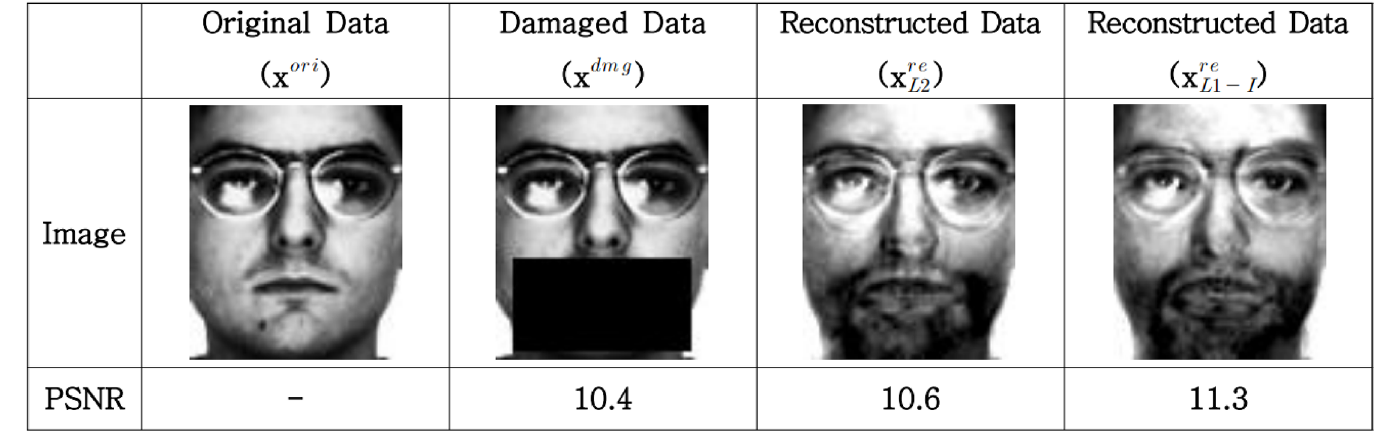
Fig 10. Reconstruction of an occluded face image.